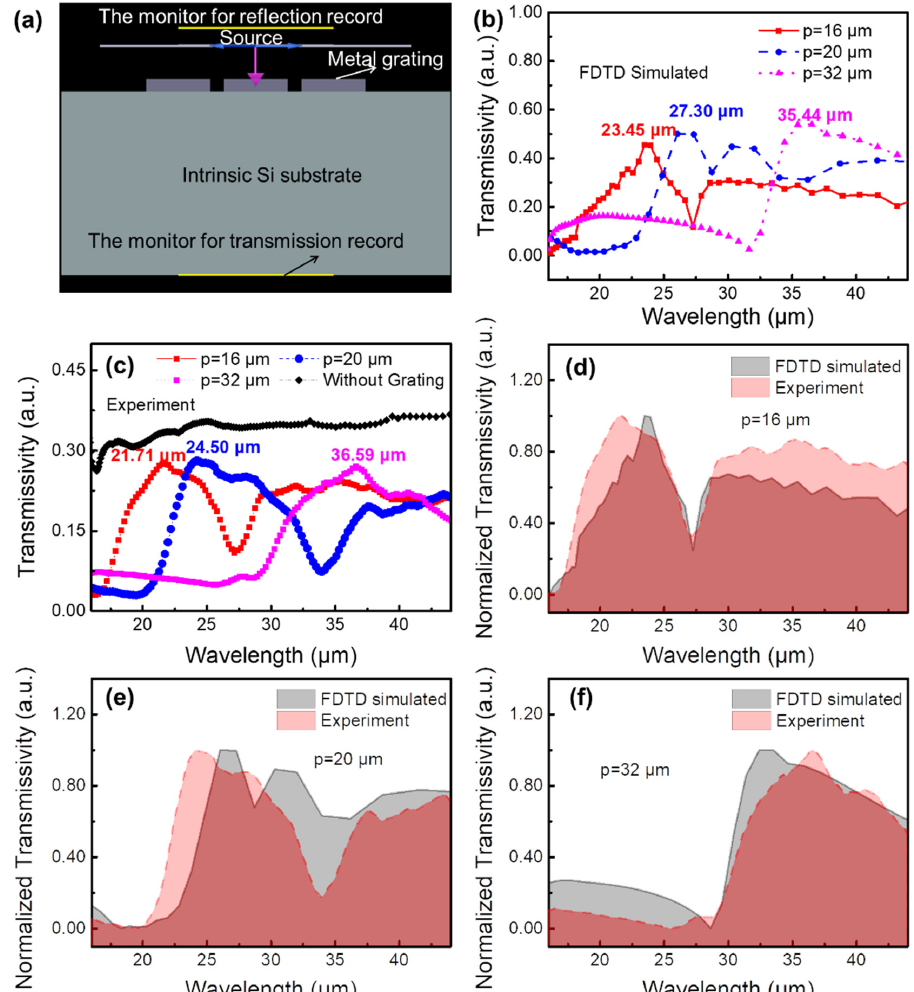
Figure 2. ( a ) FDTD model, ( b ) the simulated transmission spectra of the metal grating/Si structure, in which the periods of the metal gratings are set as 16, 20, and 32 µ m, respectively. The light source, monitors, and the device structure are marked in ( a ). ( c ) The experimental transmission spectra of the bare Si (130 μ m) substrates and the Si (130 μ m) substrates with 16, 20, and 32 μ m periods of metal grating, respectively. ( d – f ) One-by-one comparison of the normalized FDTD simulation and experimental transmission spectrum results of the three hybrid structures with different periods of metal gratings. Figure 3a shows the FDTD model of the metal grating/Si-based BIB detector. The thicknesses of the BL and the AL are set as 2 (or 5) and 10 μ m, respectively. There are two monitors, one below the BL and the other covering the entire BL and AL, which monitor the transmission of light through the BL (e.g., the incident light entering the AL) and the optical field distribution inside the device, respectively. In Figure 3b, for the devices with BLs of the same thickness, the peak position of the transmission spectrum red shifts as the metal grating period increases, which is approximately the same as that of the correspond- ing metal grating/Si (130 μ m). However, for the devices with the same period of metal grating, the incident light entering the AL for the device with the 2 μ m-thick BL is higher than that of the device with the 5 μ m-thick BL. It cannot be caused by the absorption of